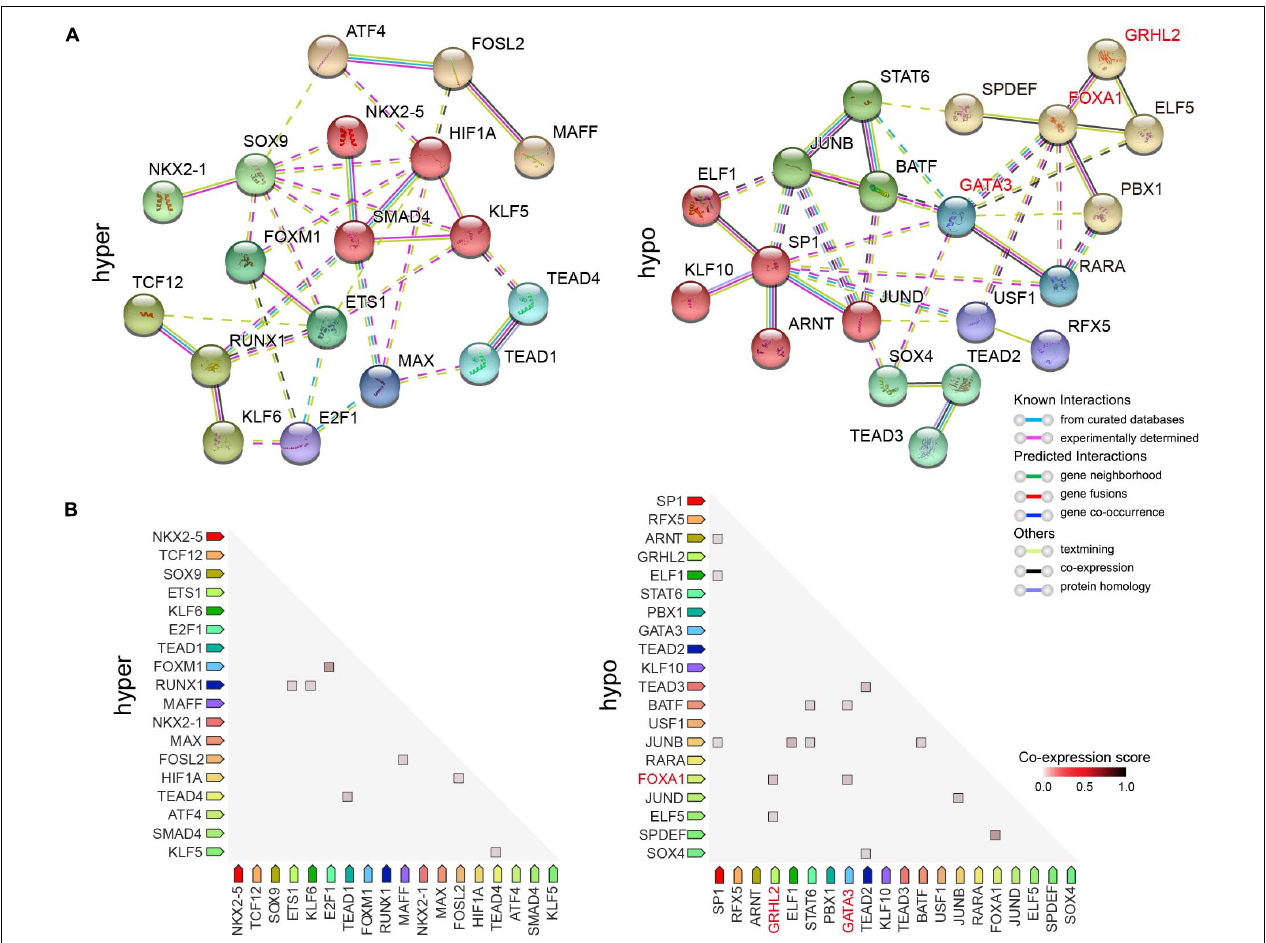
FIGURE 7 | Protein-protein interaction (PPI) and co-expression network analysis of DETFs. (A) PPI network showing DETFs identified by HOMER enriched in hyper- (left) and hypo-accessible (right) regions. Network nodes indicate proteins, and the colored edges represent evidence of different types of protein-protein interactions. Strong relationships and networks were clustered using Markov cluster algorithm by default inflation parameters and indicated by solid lines. (B) Observed co-expression in Homo sapiens identified by STRING for DETFs associated with